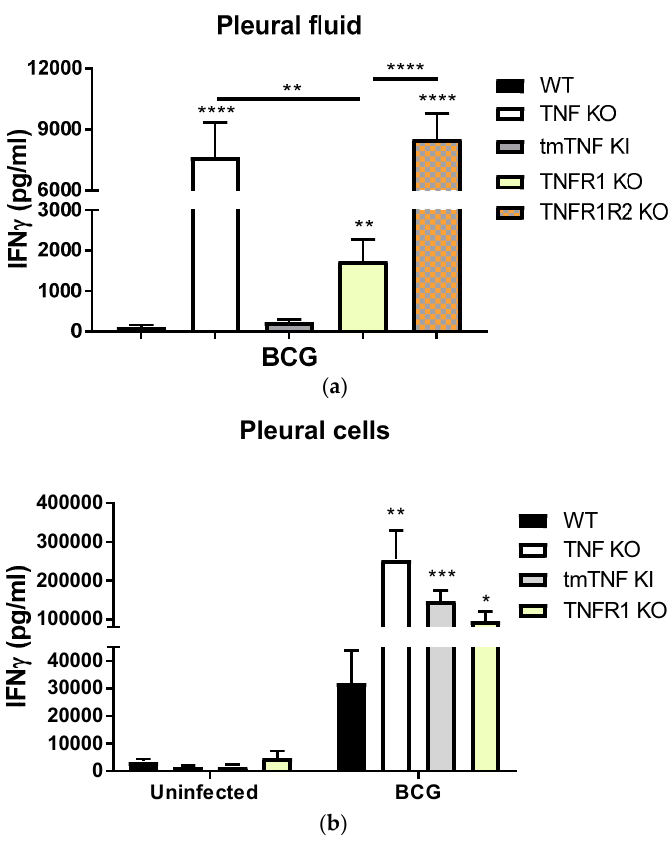
Figure 4. The inflammation in the pleural cavity after BCG-induced pleurisy in mice. ( a ) Concentrations of IFN- γ in the pleural cavity of BCG-infected mice at day 14 post-infection. Data are represented as bar graphs showing means +/ − SEM ( n = 12, TNFR1R2 KO n = 8). Comparisons are done with WT mice and as indicated in the figure ** p < 0.01 and **** p < 0.0001; ( b ) Amounts of IFN- γ measured in the supernatants of pleural cells isolated from BCG-infected mice and cultured without or with BCG (MOI 1) for 24 h. Data are represented as bar graphs showing means +/ − SEM ( n = 6–10 per group). Comparisons are done with WT mice, * p < 0.05, ** p < 0.01, *** p < 0.001.